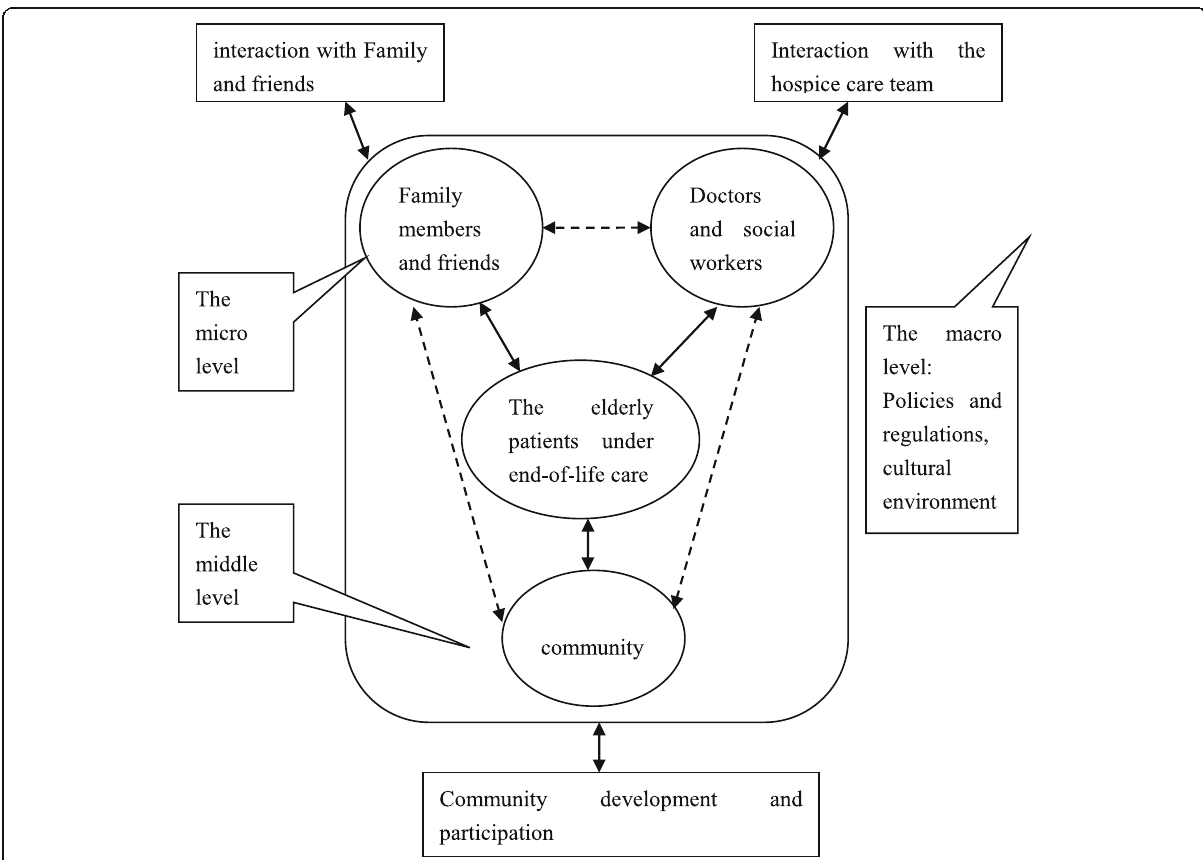
Fig. 2 the service demand analysis model of the elderly patients under end-of-life